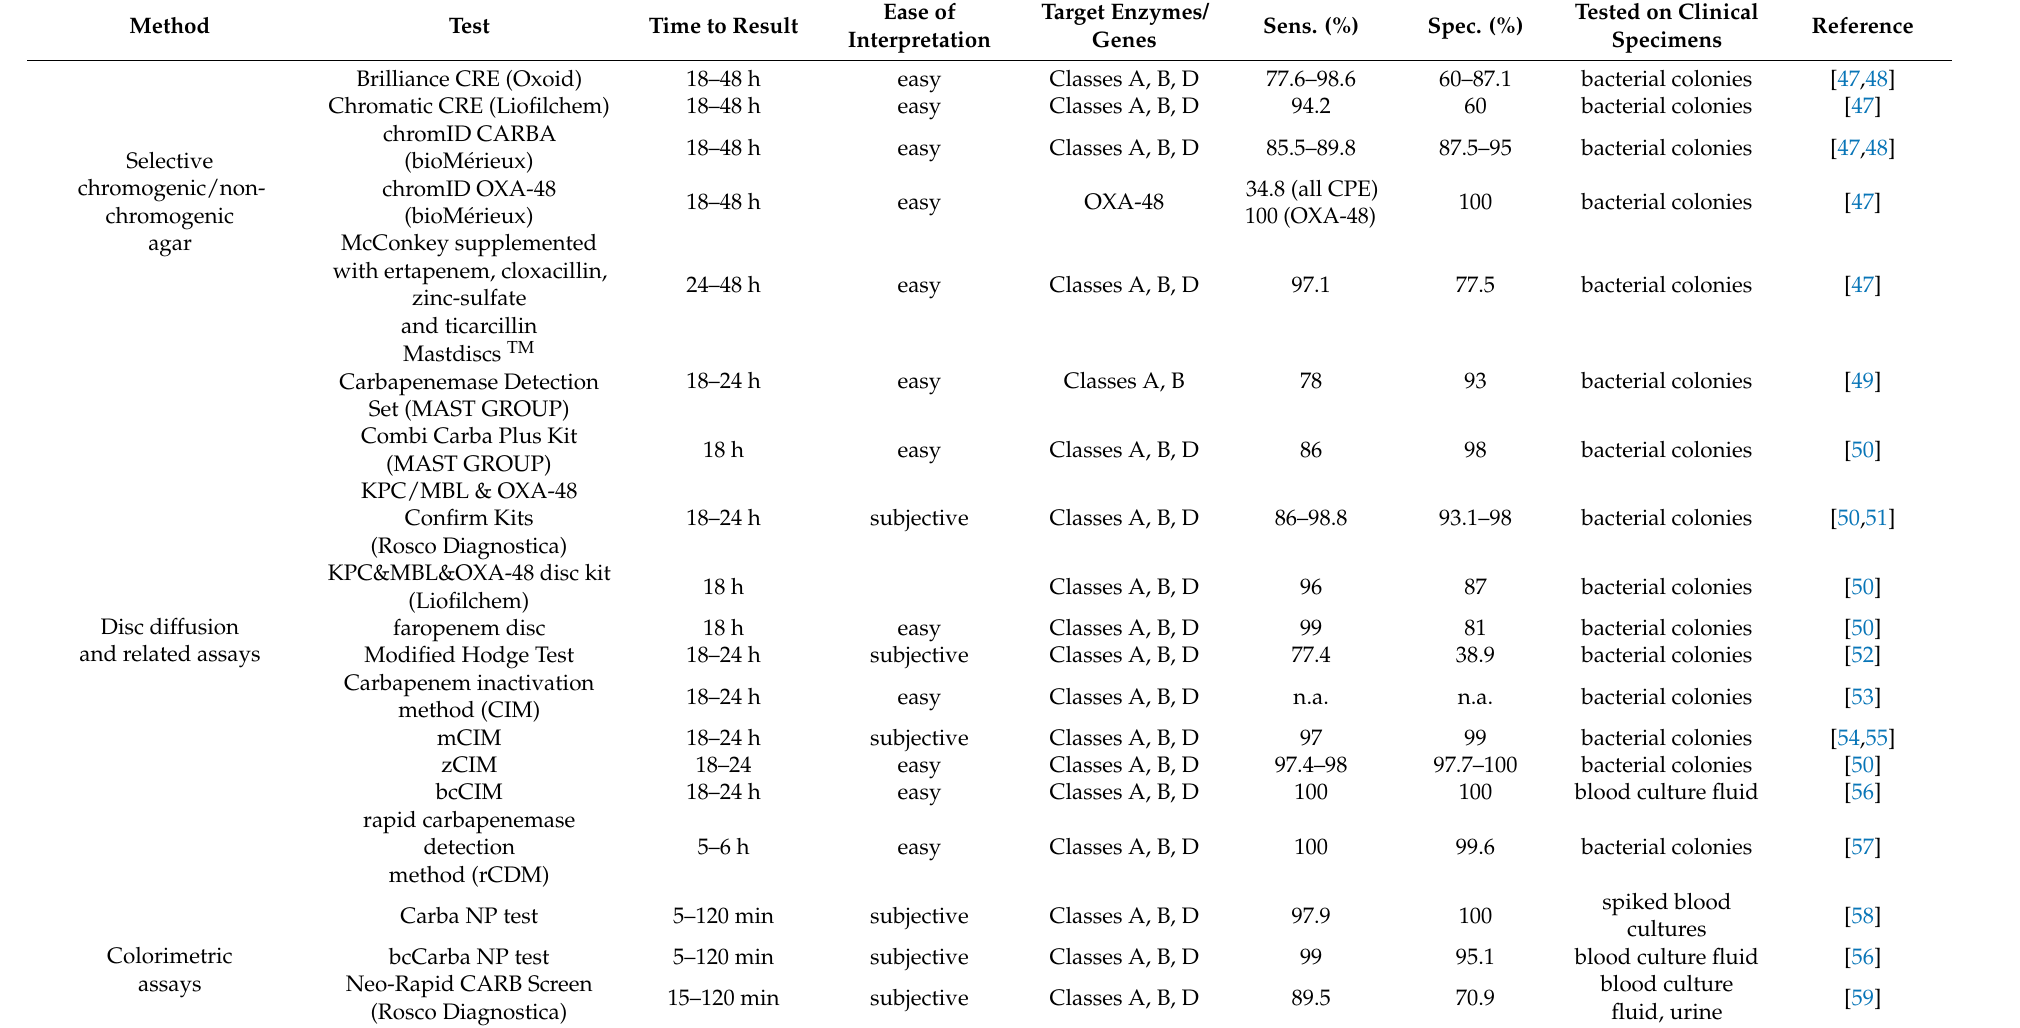
Table 1. Overview of selected versions of carbapenemase detection methods available for Enterobacterales . Table modified from